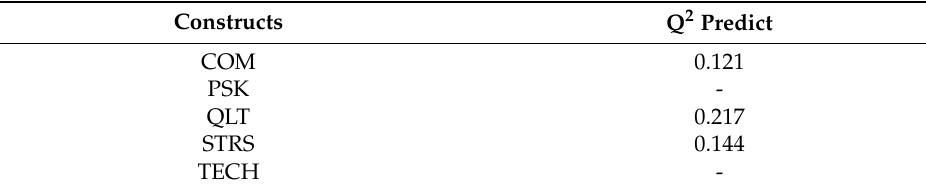
Table 8. Cross-validated